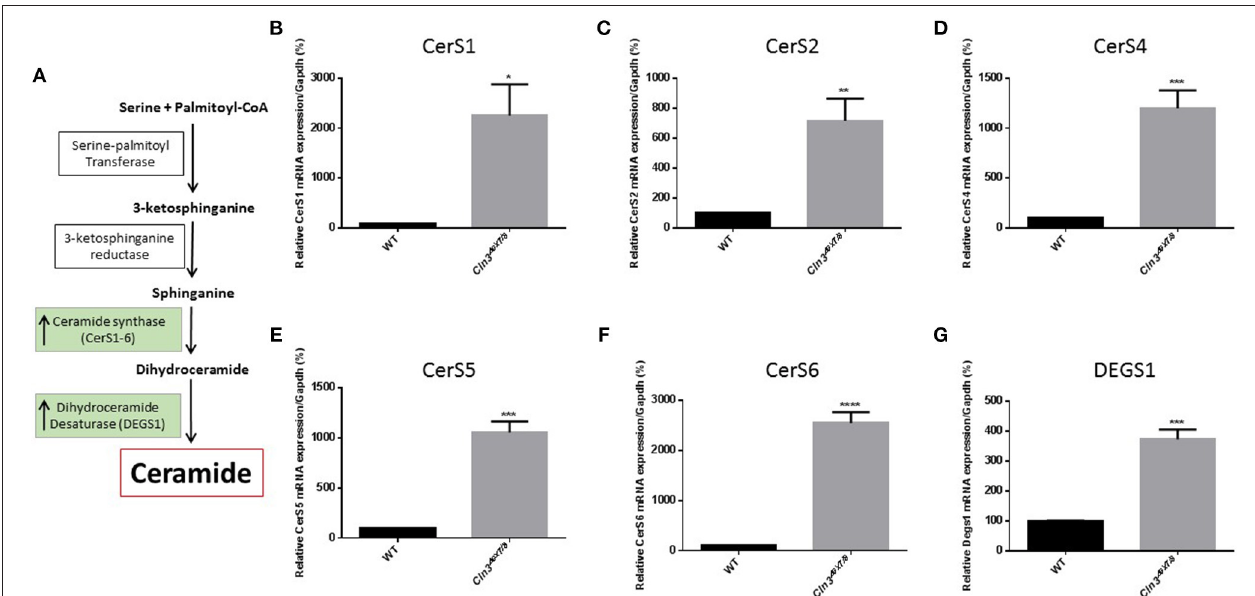
FIGURE 2 | (A) De novo synthesis pathway for generation of ceramide in ER. Relative expression of de novo ceramide synthesis enzymes: CERS1 (B) (* P < 0.05), CERS2 (C) (** P < 0.01), CERS4 (D) (*** P < 0.001), CERS5 (E) (*** P < 0.001), CERS6 (F) (**** P < 0.0001), and DEGS1 (G) (*** P < 0.001) in WT and Cln3 ∆ ex7/8 mouse brain at 44 weeks of age ( n = 4 in each group). Enzymes are substantially upregulated in Cln3 ∆ ex7/8 whole mouse brain compared to 44 weeks-old age-matched WT